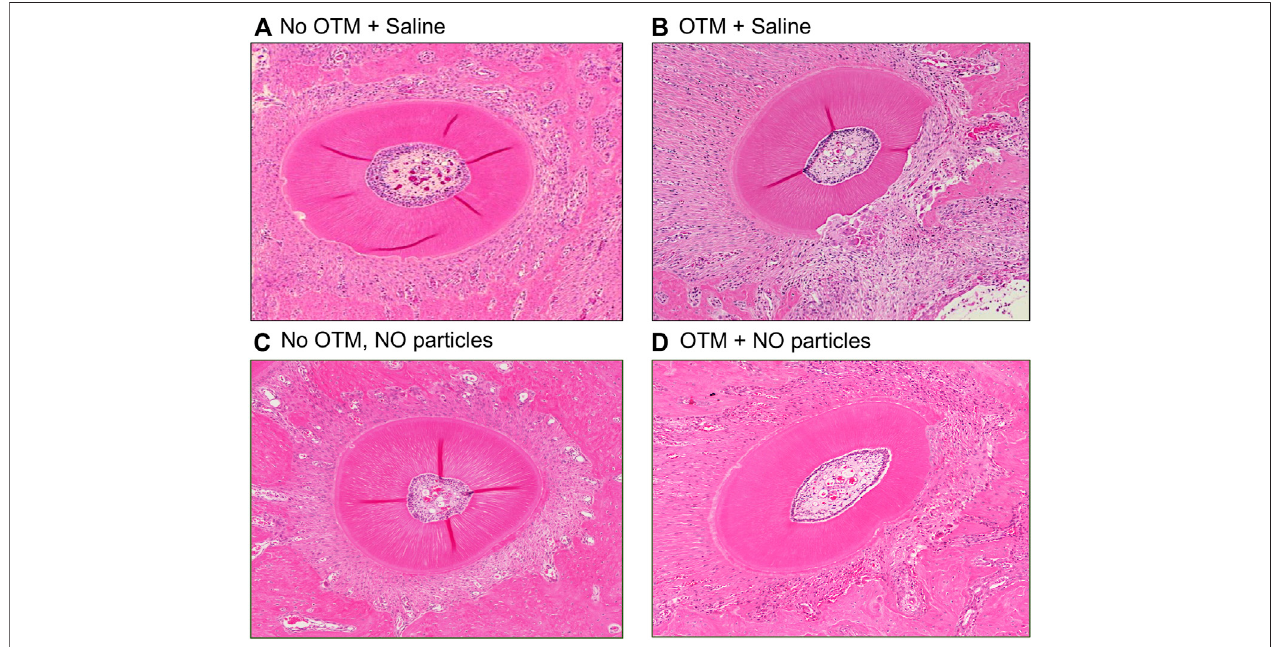
FIGURE 4 | NO releasing biomaterial inhibits molar but not incisor tooth movement. (A) Mesial molar tooth movement over the 18-day experimental period. Means ± standard deviations are shown. Animals that had orthodontic appliances plus NO releasing nanoparticles showed signi fi cantly diminished mesial molar tooth movement at all time points as compared to animals that had orthodontic appliances but not NO releasing nanoparticles. * p < 0.05, ** p < 0.005 between groups. Note diminished slope of tooth movement for animals with NO releasing nanoparticles compared to that for animals without NO releasing nanoparticles from days 1 – 6 that increases to match that of animals without NO releasing nanoparticles by days 12 – 18. (B) Distal incisor tooth movement at the end of the 18-day experimental period.Nosigni fi cantdifferences werefoundforincisormovement betweengroups(PBSmean=1.92,NOmean=1.90,95%con fi denceintervalofdifferencebetween the means = − 0.26 to +0.22). Whisker plots showing medians, interquartile range, minimum and maximum values are